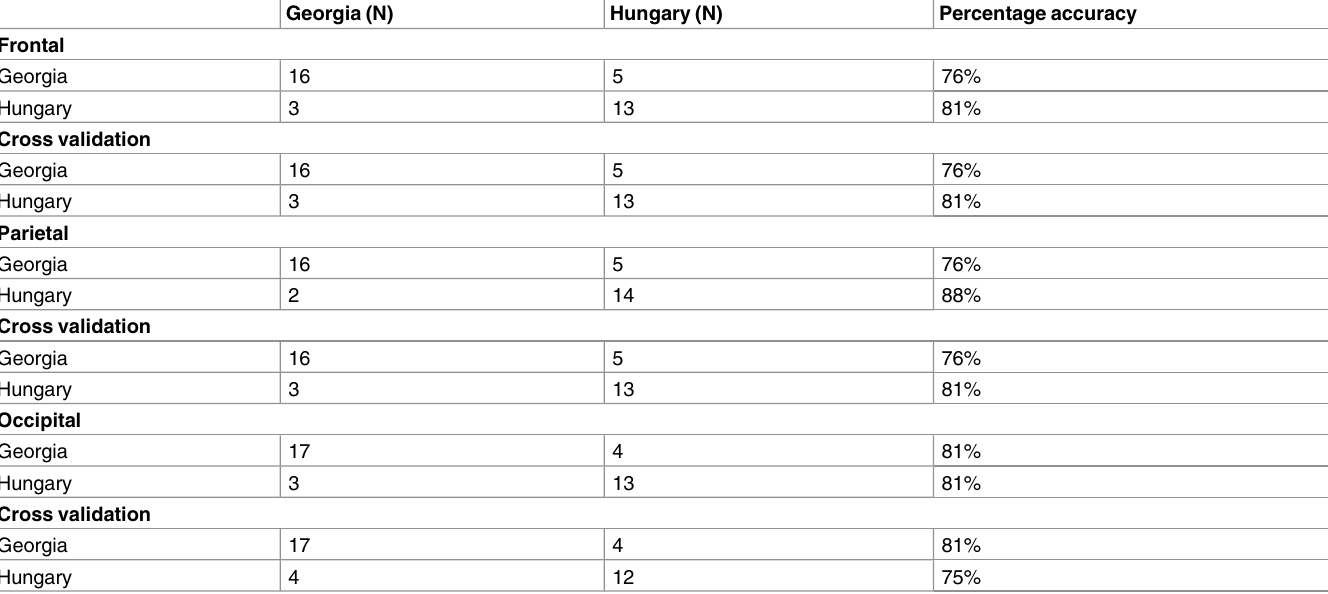
Table 3. Classification accuracyfrom discriminant analysis of frontal, parietal and occipital